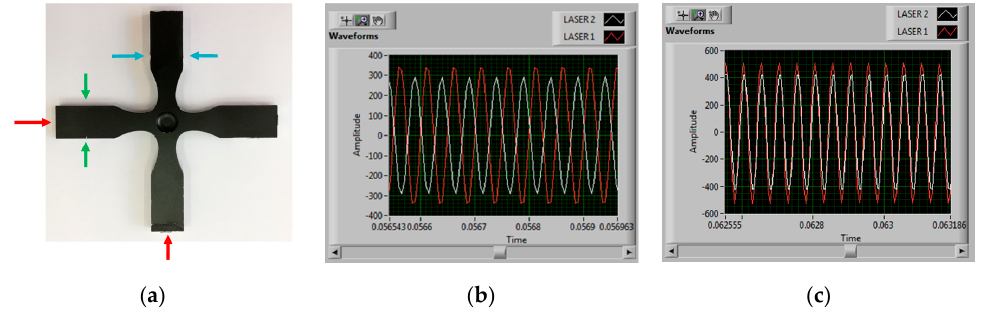
Figure 27. ( a ) Photo of one manufactured specimen; ( b ) deformation waveform at the end of C-T in the axial direction (out-of-phase); ( c ) deformation waveform at the end of T-T in the axial direction